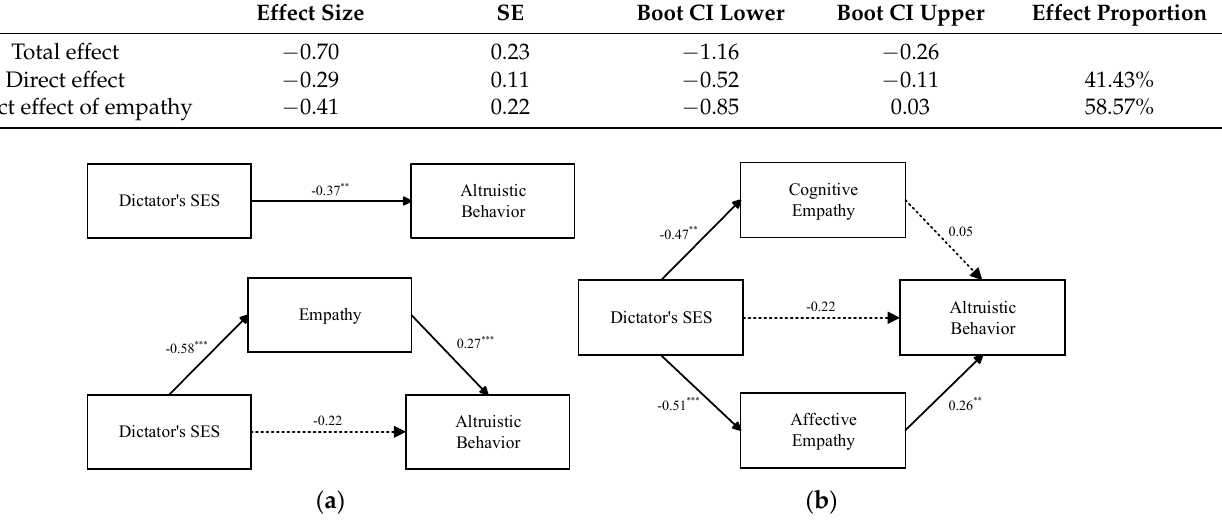
Figure 3. ( a ) Empathy as the mediator of the association between dictator’s SES and altruistic behavior in poor-recipient condition. ( b ) Cognitive empathy and affective empathy as mediators of the association between dictator’s SES and altruistic behavior in poor-recipient condition. Note: Dictator’s SES: 0 = low SES, 1 = high SES. ** p < 0.01. *** p < 0.001.